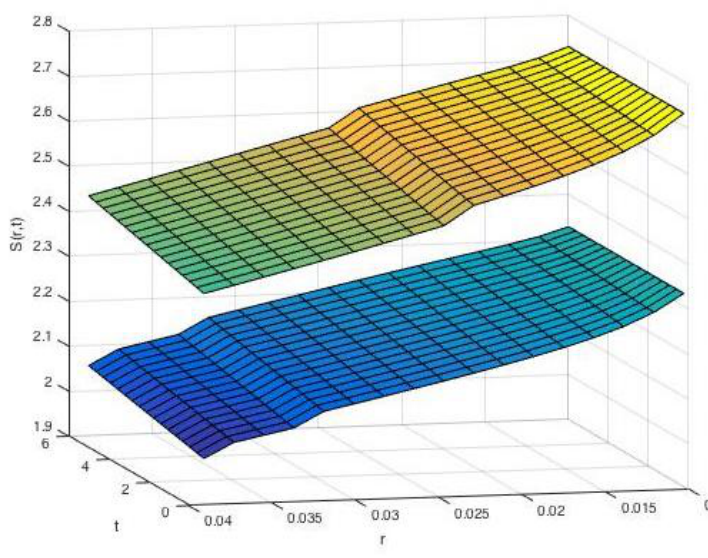
Figure 2. Multi Migration Free